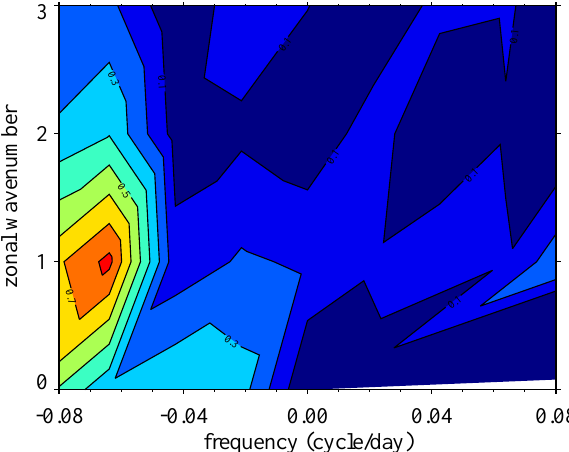
Fig. 3. Normalized frequency–wavenumber spectrum based on the TIMED/SABER temperature observations at 90km in the zone of 18.8–22.8 ◦ N for 48 days from 2 November to 19 December 2003. The negative and positive frequencies denote the westward and east- ward propagations, respectively.